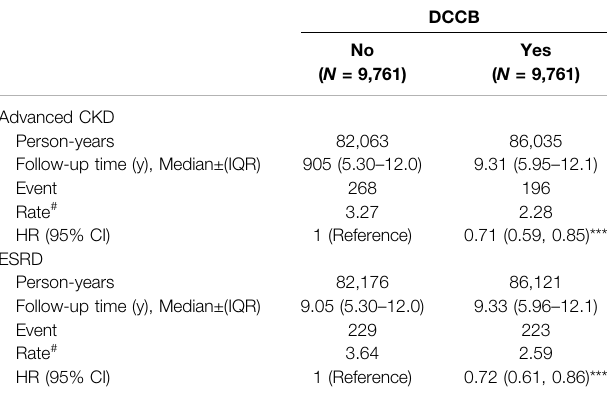
TABLE 2 | Incidence and HRs of advanced CKD or ESRD in the dihydropyridine calcium channel blocker (DCCB) cohorts compared with those in the non- DCCB cohorts among diabetes mellitus patients with chronic kidney disease by Cox proportional hazard models with time-dependent exposure covariates.